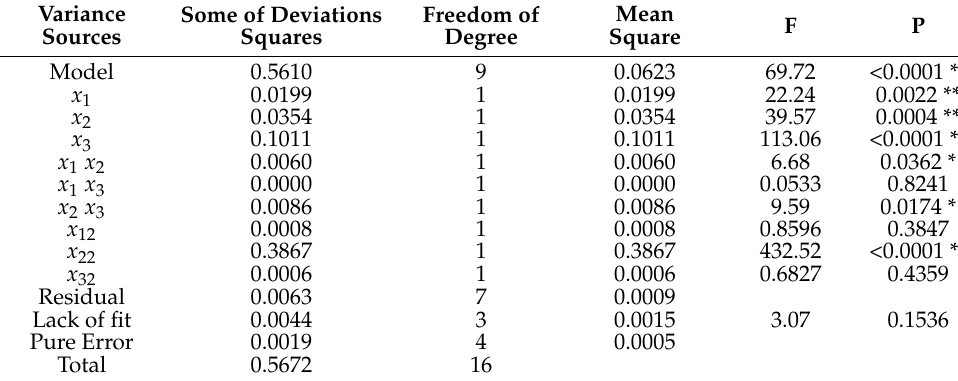
Table 4. Analysis of variance for maximum shear stress. Variance